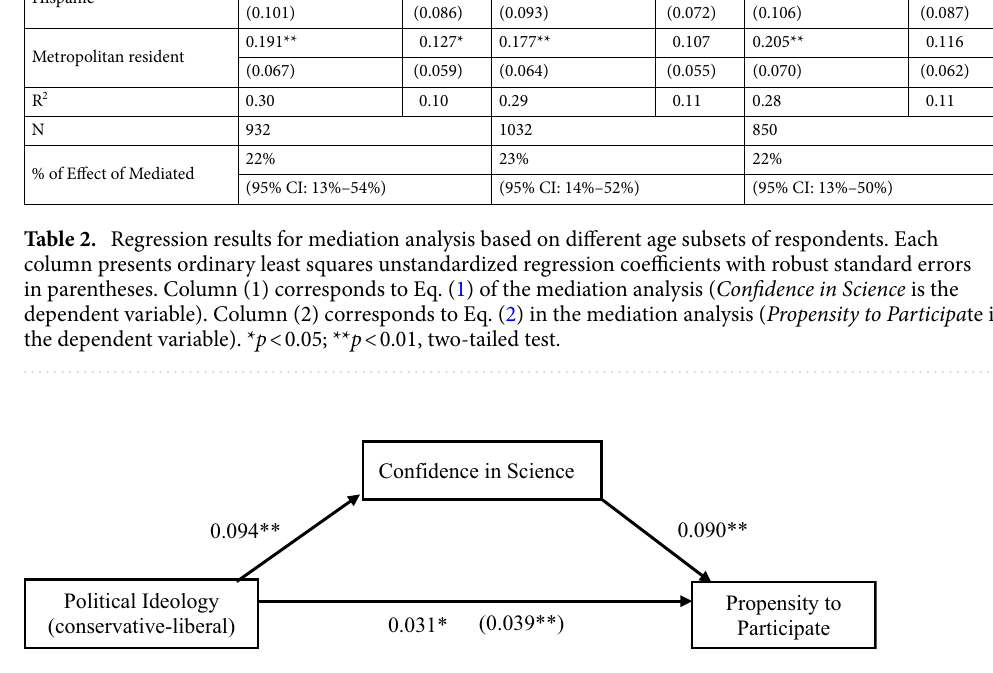
Figure 3. The effect of political ideology on propensity to participate in medical research partially mediated by confidence in science. The values in the figure represent standardized regression coefficients. The value in parentheses is for the total effect of political ideology, which was estimated in a regression without confidence in science. All regressions included controls for confidence in institutions, gender, residence in metropolitan